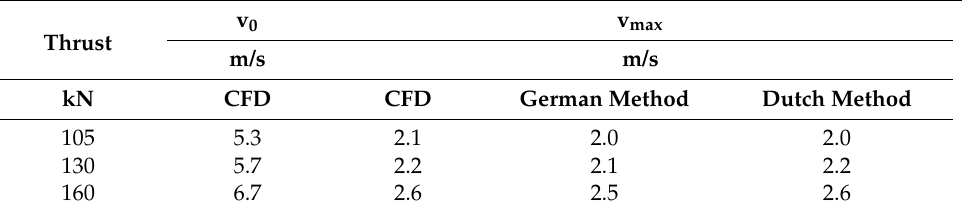
Table 5. Maximum velocities generated by the bow thrusters on the seabed—CFD simulation results compared to the German and Dutch